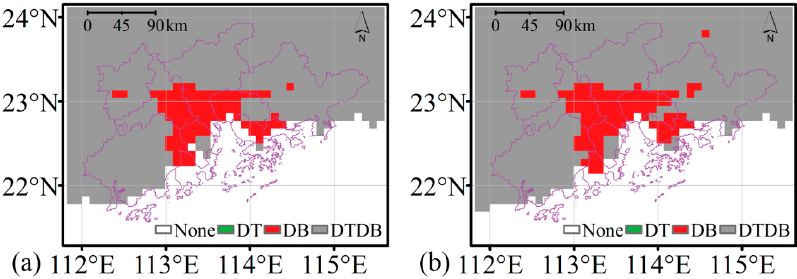
Figure 9. Seasonal distributions of multi-year averaged MODIS NDVI data for 2006–2015.